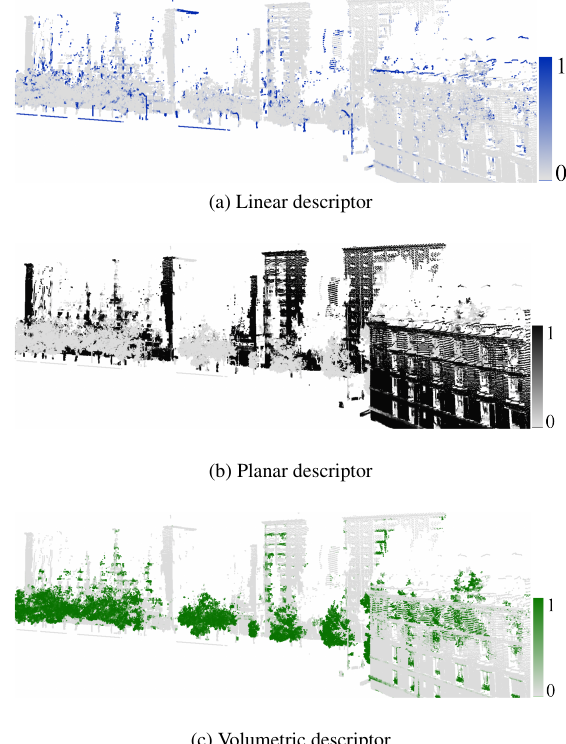
Figure 4: Response of the different geometrical descriptors after probabilistic relaxation.